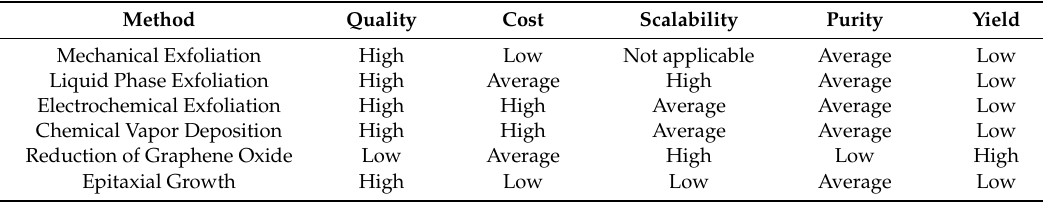
Table 1. Comparison of methods for manufacturing